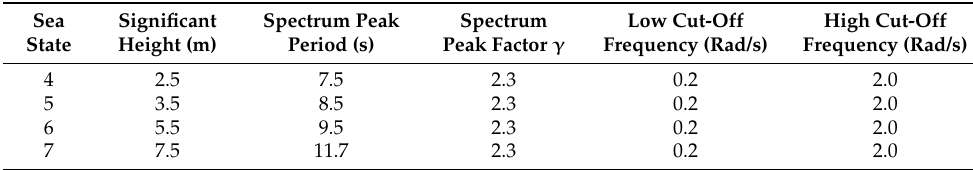
Figure 6. Wave spectrum. Table 4. Wave spectrum parameters for numerical simulation. Table 4. Wave spectrum parameters for numerical simulation. Significant Spectrum Peak Sea State Height (m) Period (s)